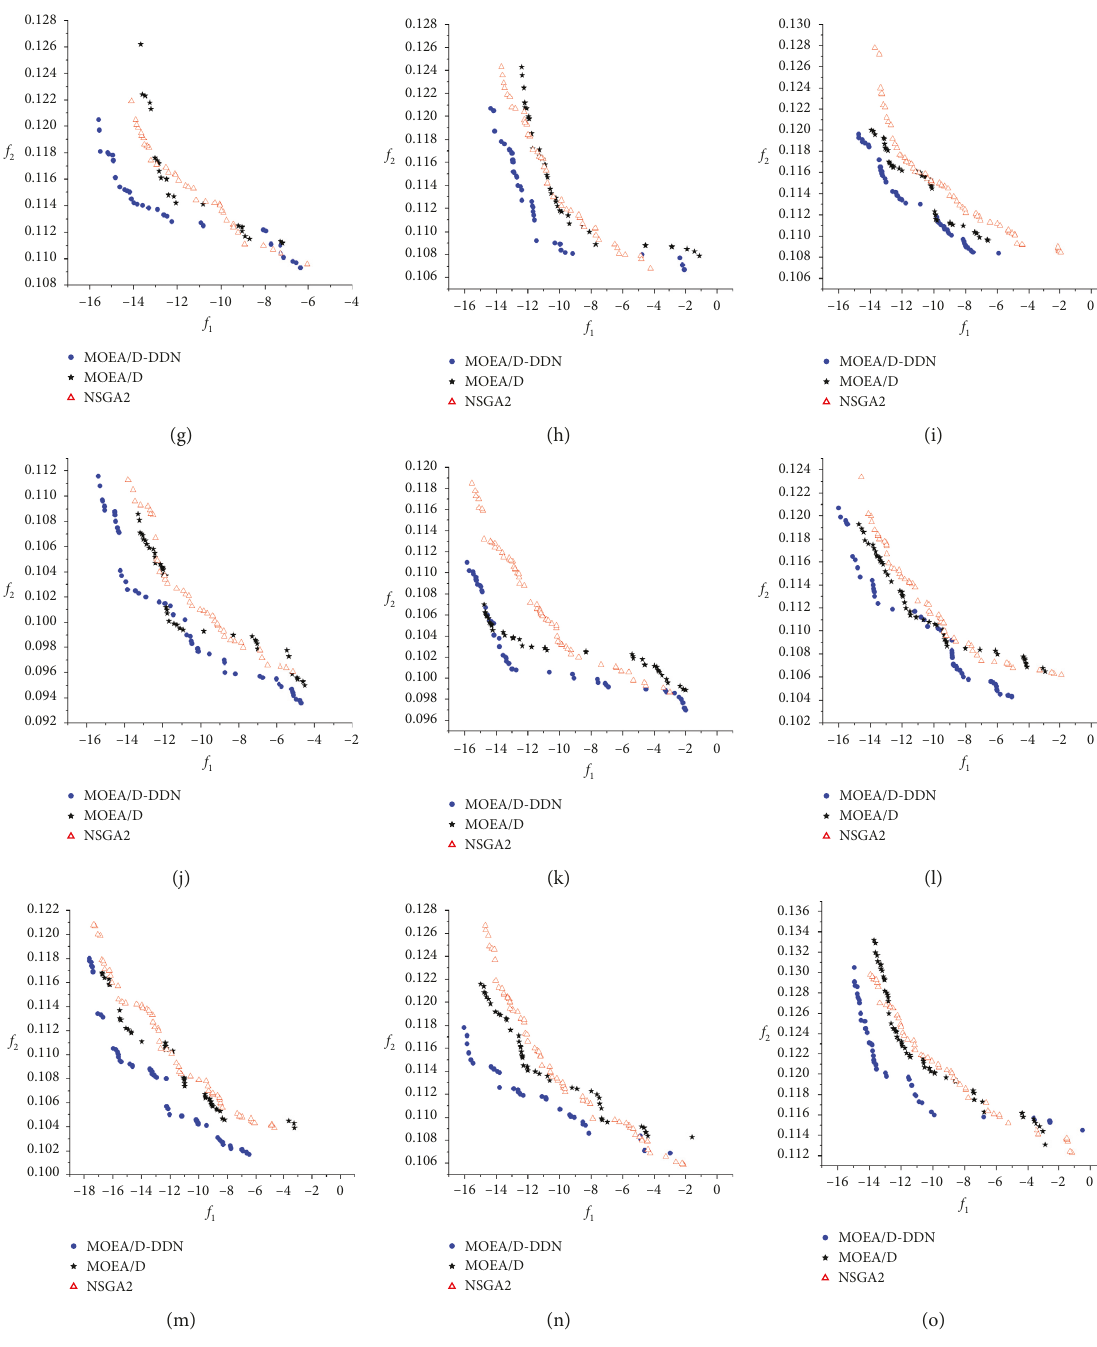
Figure 13: Obtained approximation of Pareto optimal solutions by MOEA/D-DDN, MOEA/D, and NSGA-II: (a) instance 1; (b) instance